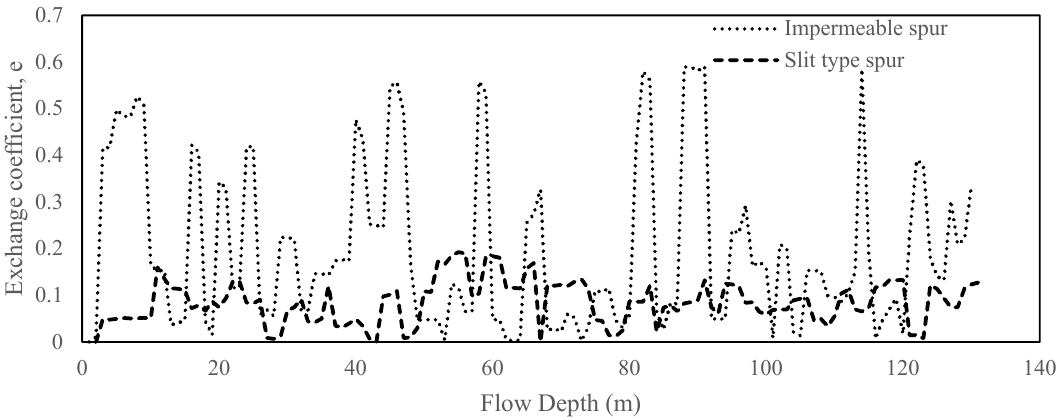
Figure 19. The distribution of exchange coefficient inside the third embayment.